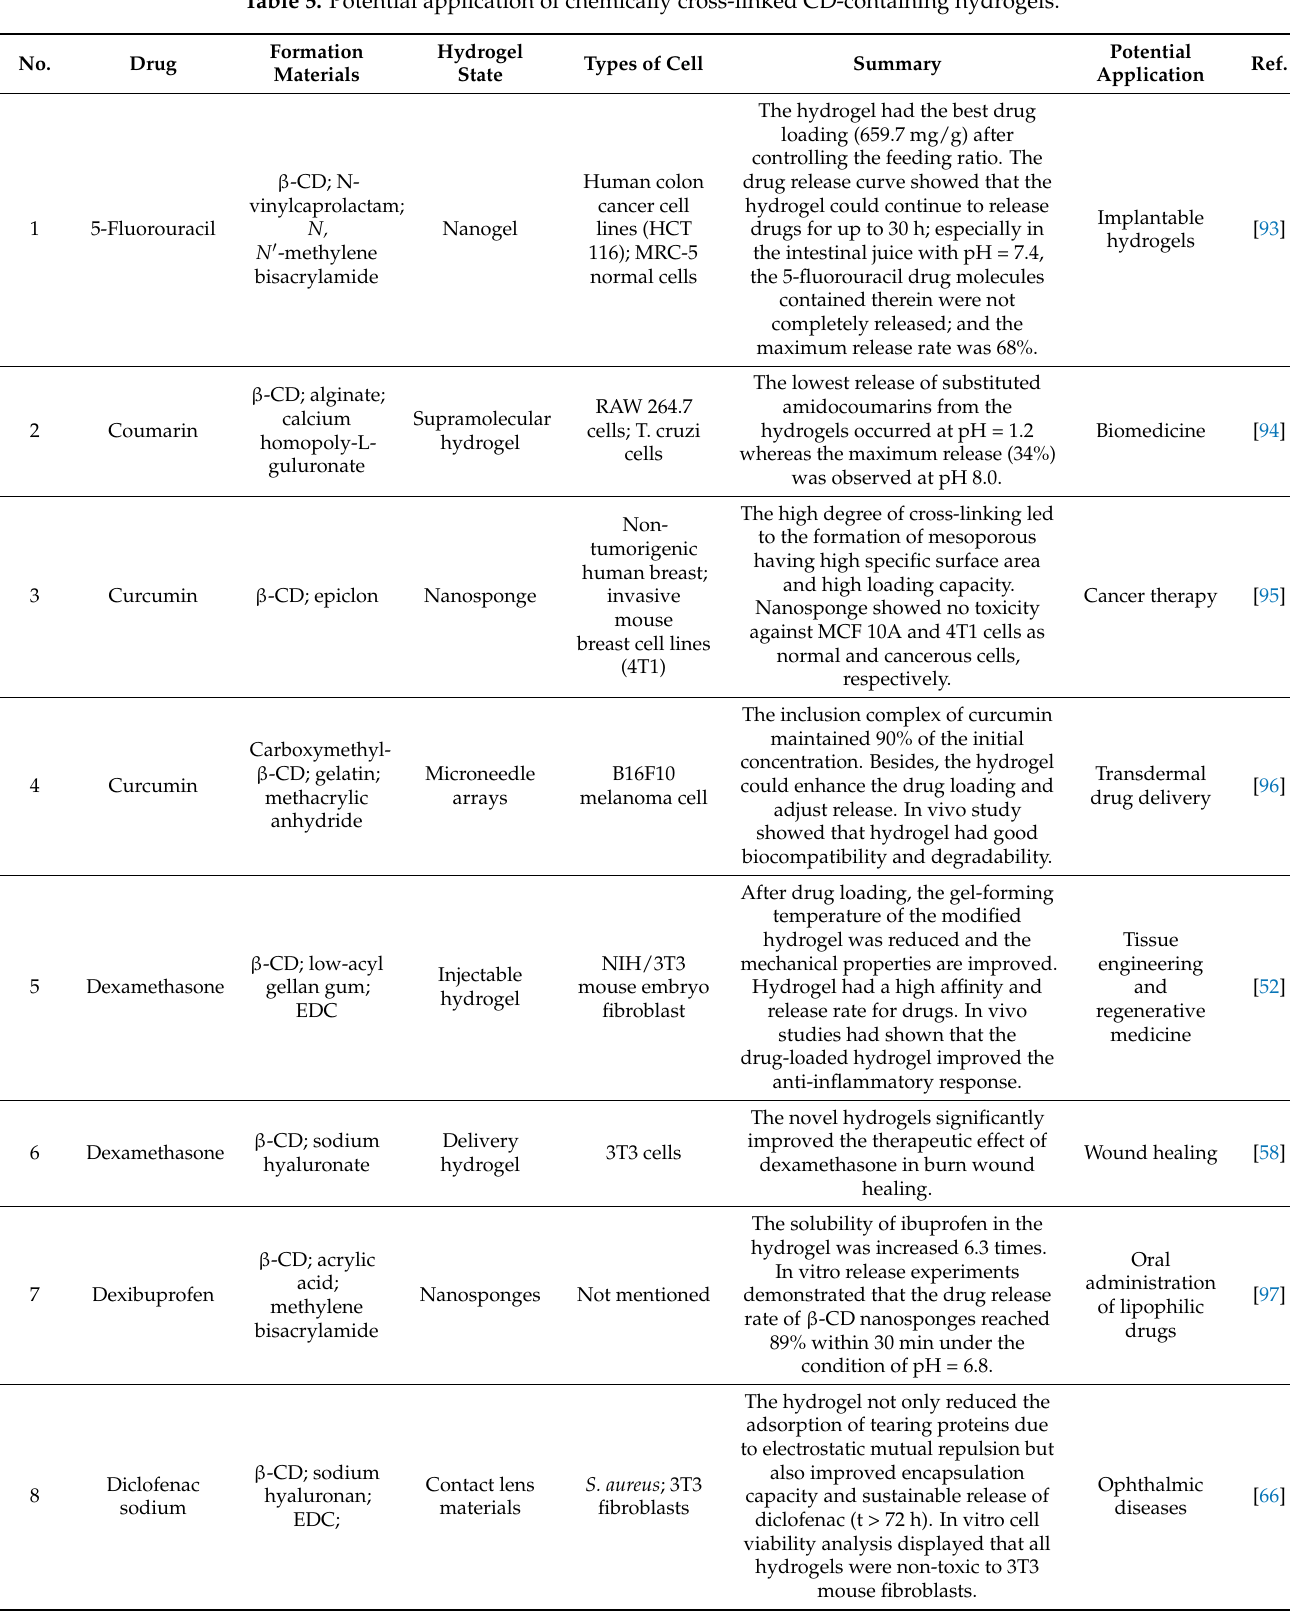
Table 5. Potential application of chemically cross-linked CD-containing